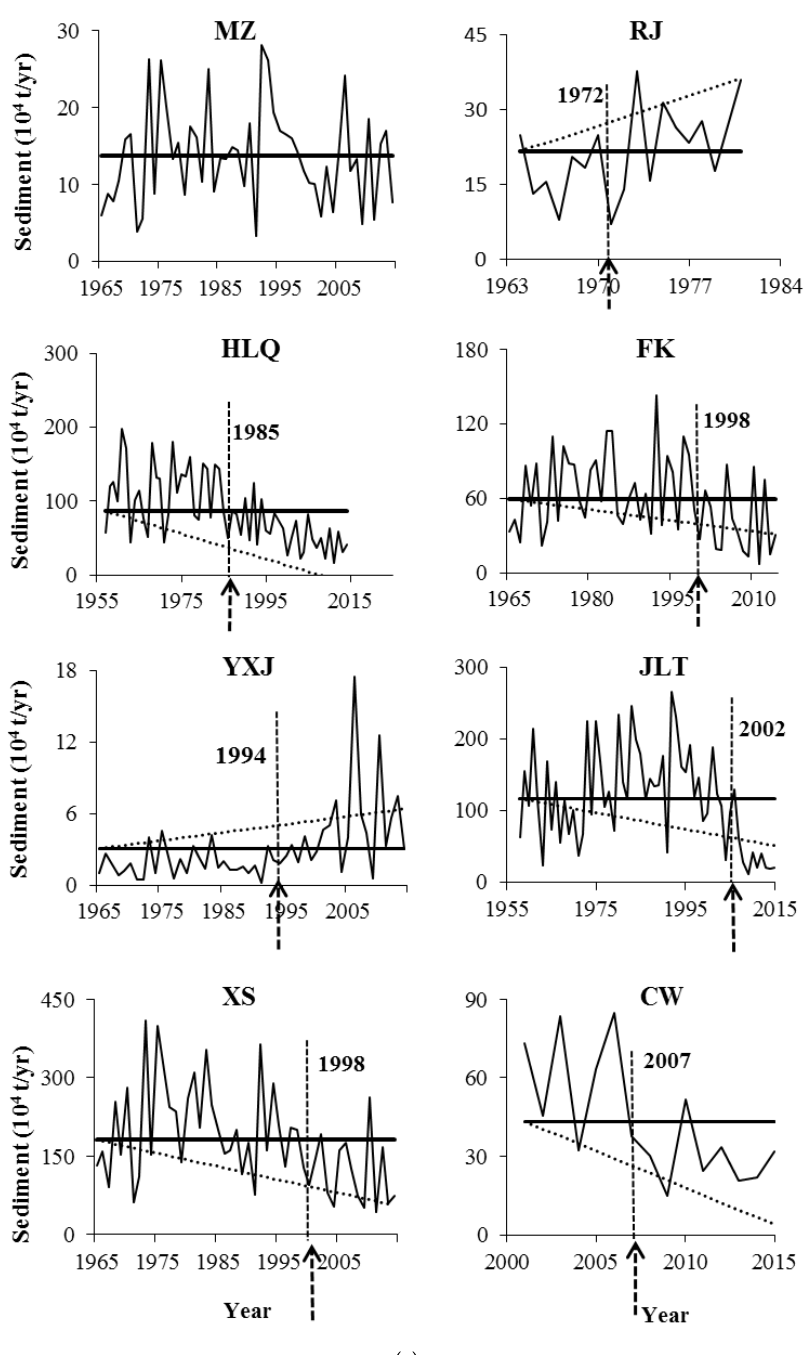
Figure 2. ( a ) Observed annual precipitation during 1950–2015 at eight hydrological stations on the Gongshui River of Ganjiang River basin. The horizontal solid and dashed lines are the mean values and trend lines, respectively. ( b ) Observed annual streamflow during 1950–2015 for the Gongshui River basin. ( c ) Observed annual sediment discharge of the Gongshui River of Ganjiang River basin. Note: MZ, RJ, FK, HLQ, YXJ, JLT, XS, and CW are abbreviations for Mazhou, Ruijin, Fenkeng, Hanlinqiao, Yangxinjiang, Julongtan, Xiashan, and Chawu, respectively. The horizontal solid and dashed lines are the mean values and trend lines, respectively, and the vertical dashed lines indicate the transition